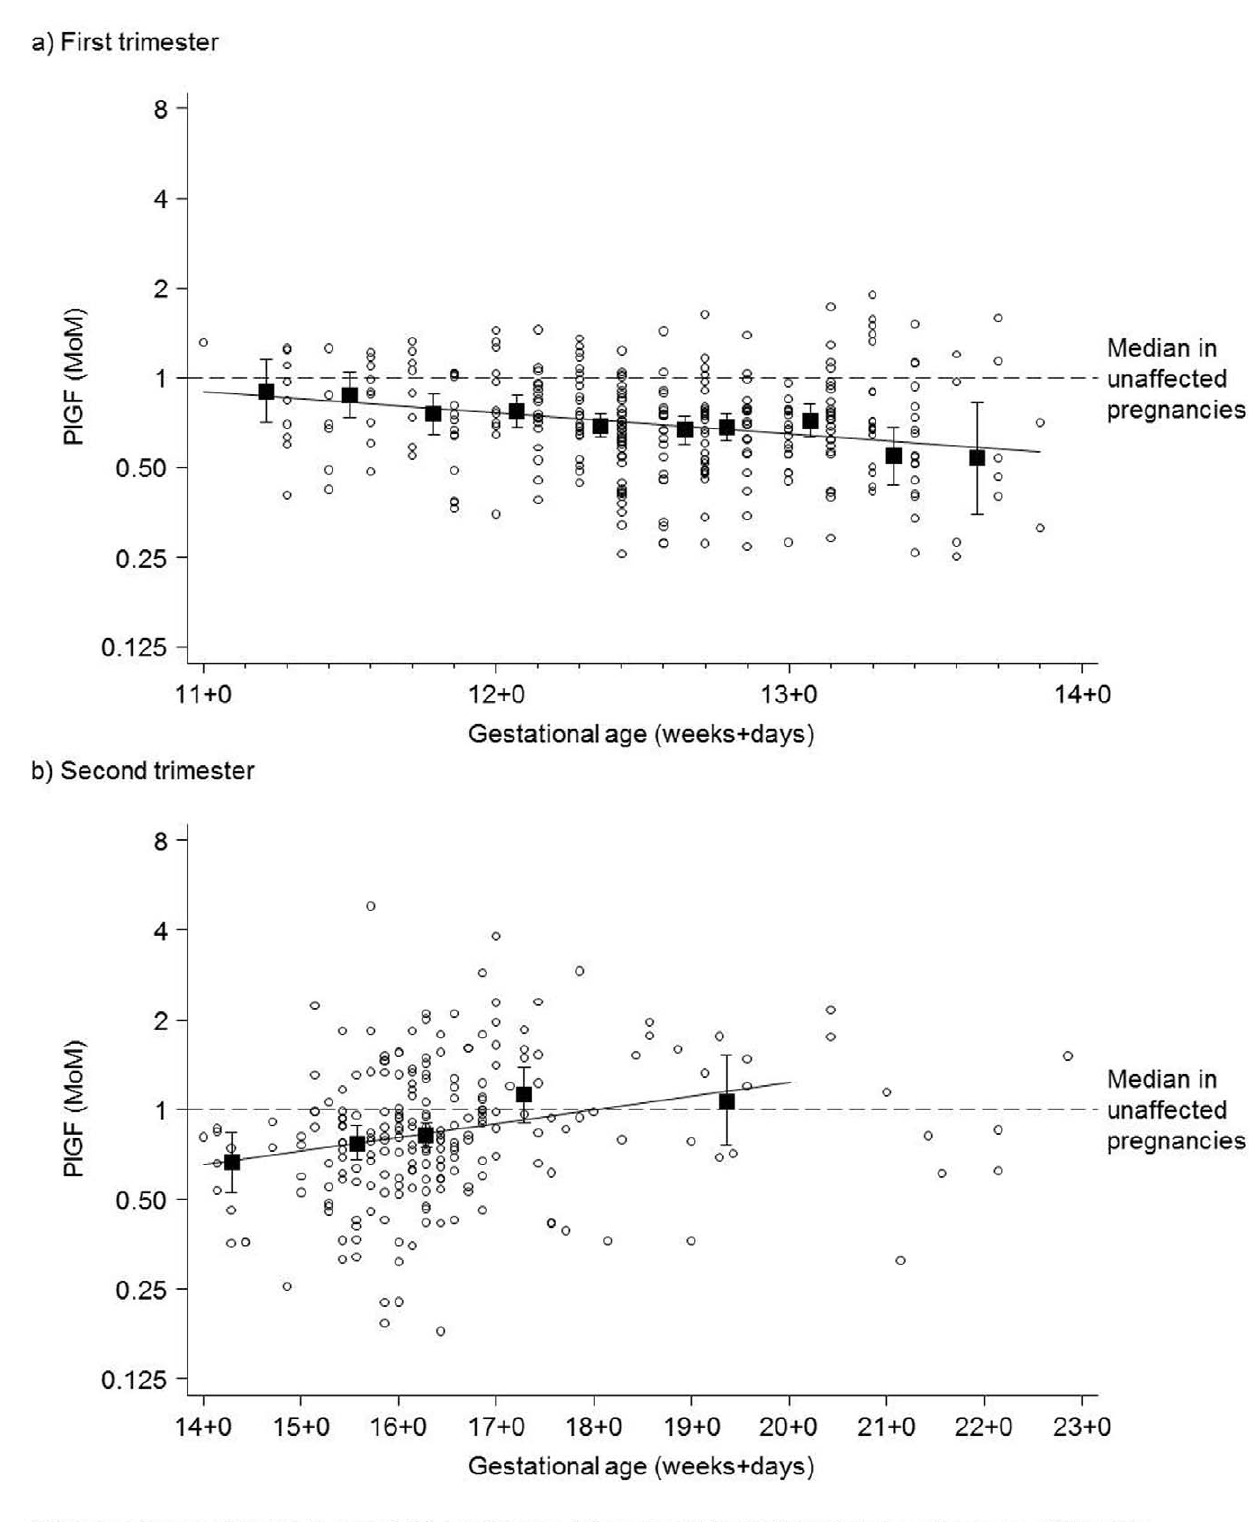
Figure 2. First trimester (a) and second trimester (b) placental growth factor (PlGF) maternal weight, smoking and ethnicity adjusted MoM values according to gestational age and medians (squares, with 95% confidence intervals) in 2-day intervals* (a) and weekly intervals (b) in Down syndrome pregnancies together with expected (regressed) median.